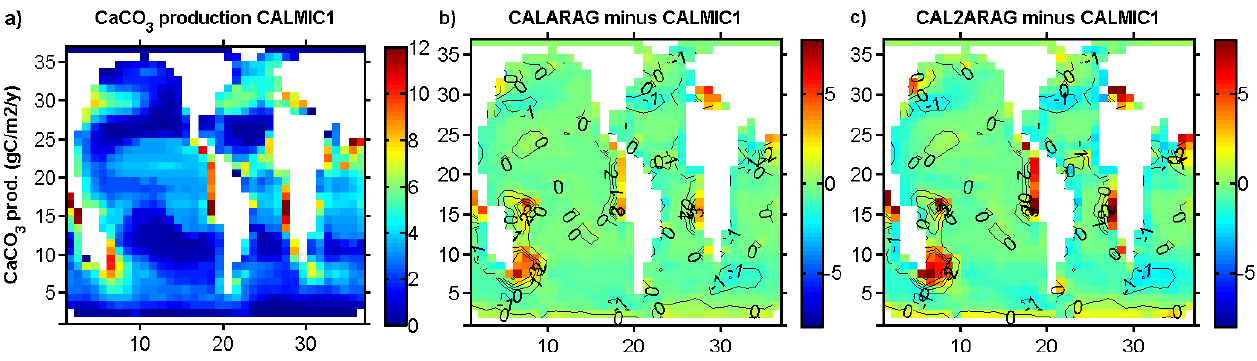
Fig. 3. Vertically integrated CaCO 3 production for (a) the version CALMIC1 that represents calcite production by nanophytoplankton only, (b) the difference to version CALARAG that represents calcite and aragonite production and (c) the difference to CAL2ARAG that represents calcite production by nanophyto- and mesozooplankton and aragonite